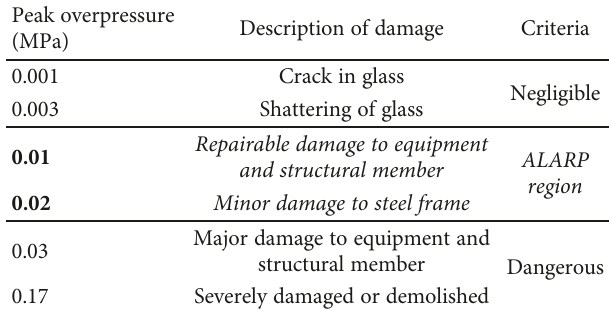
Table 6: The in fl uence of peak